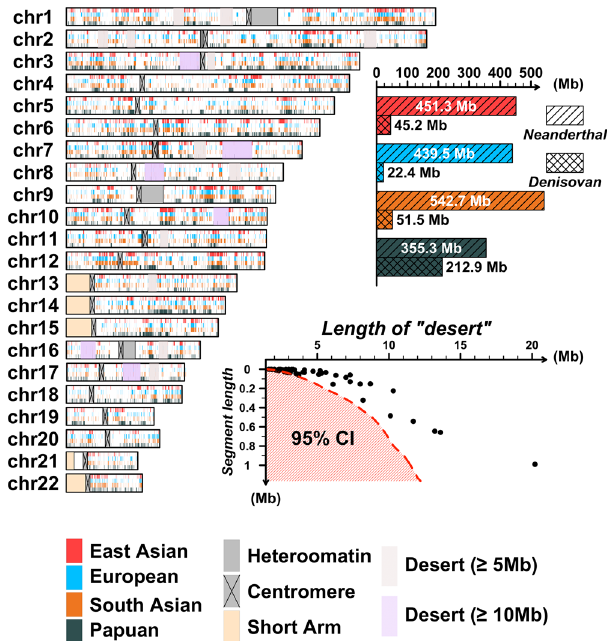
Fig. 2 The landscape of archaic introgression in non-Africans. This fi gure demonstrates the genomic coverage of archaic introgression in four different continental/regional populations. To eliminate the in fl uence of sample size, we set a minimal introgression frequency threshold of each position as 0.02. Regions with introgression frequency greater than 0.02 were de fi ned as introgression-covered regions. We plotted the introgression-covered regions on the genome, where four different colors stand for the four different continental/ regional populations, respectively. Red stands for East Asian populations; light blue stands for European populations; orange stands for South Asian populations; and dark blue stands for the Papuan population. The boxplot shows the total introgression-covered length of Neanderthal and Denisovan ancestry for the four different populations. We also performed a test of introgression “ deserts. ” We fi rst divided the genome into thousands of 100-kb bins. Then, we obtained the empirical distribution of introgression-covered length. A two-tailed test was performed to fi nd those genomic regions with extremely rare introgression segments. For the detailed statistical method, please refer to Supplementary Note 5. The red shadow indicates the 95% con fi dence interval and each black dot stands for one introgression “ desert. ” We also plotted the long “ desert ” on the genome with two different colors. Purple on the genome stands for “ deserts ” longer than 10Mb, and brown stands for “ deserts ” longer than